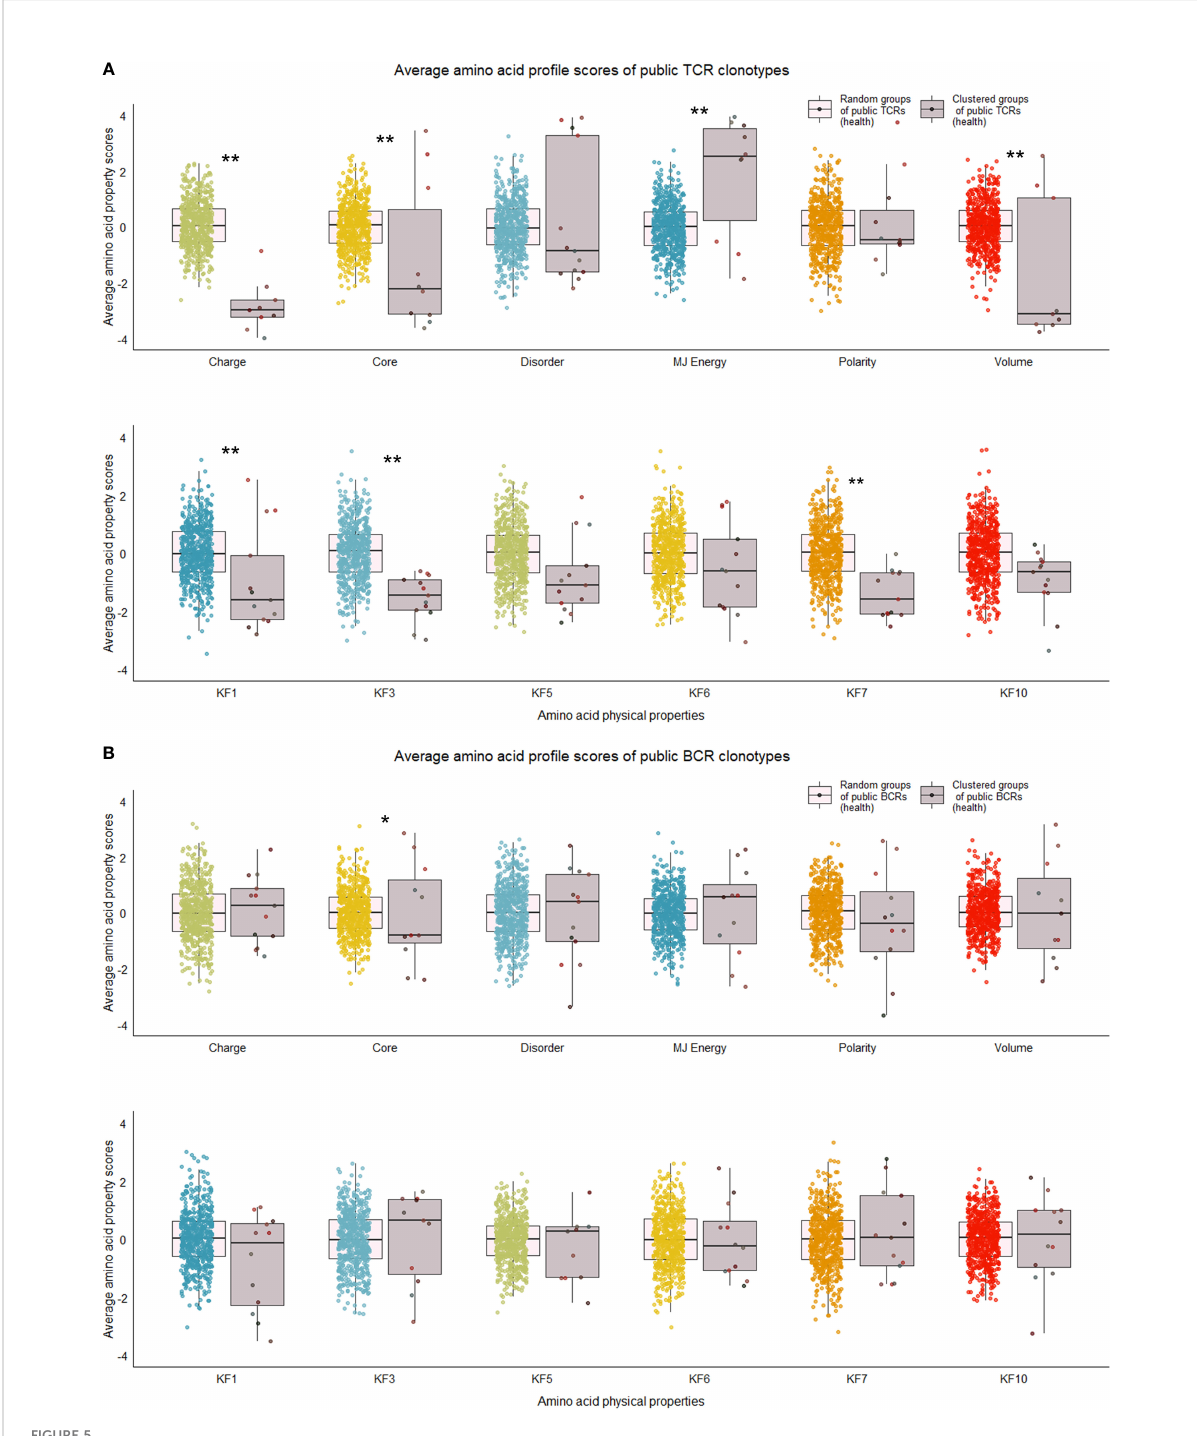
FIGURE 5 Distribution of average amino acid property scores for selected clusters of public BCR and TCR amino acid sequences compared to random groups of public BCR and TCR amino acid sequences from healthy immune repertoires. (A) Boxplots of scaled average amino acid physical property scores of TCR amino acid sequences from selected clusters (mauve colors) compared to those of randomly selected T cell clonotype groups (rainbow colors) of healthy individuals. (B) Boxplots of scaled average amino acid physical property scores of BCR amino acid sequences from selected clusters (mauve colors) compared to those of randomly selected B cell clonotype groups (rainbow colors) of healthy individuals. Dots represent averages of each cluster or random group. P -values are from Kolmogorov-Smirnov tests for difference of two distributions, i.e. averages of random groups of amino acid sequences and averages of clustered clonotype sequences. ** P -value< 0.005. * P -value< 0.05. KF kidera factors (KF1 helix/bend preference, KF3 extended structure preference, KF5 double-bend preference, KF6 partial speci fi c volume, KF7 fl at extended preference, KF10 surrounding